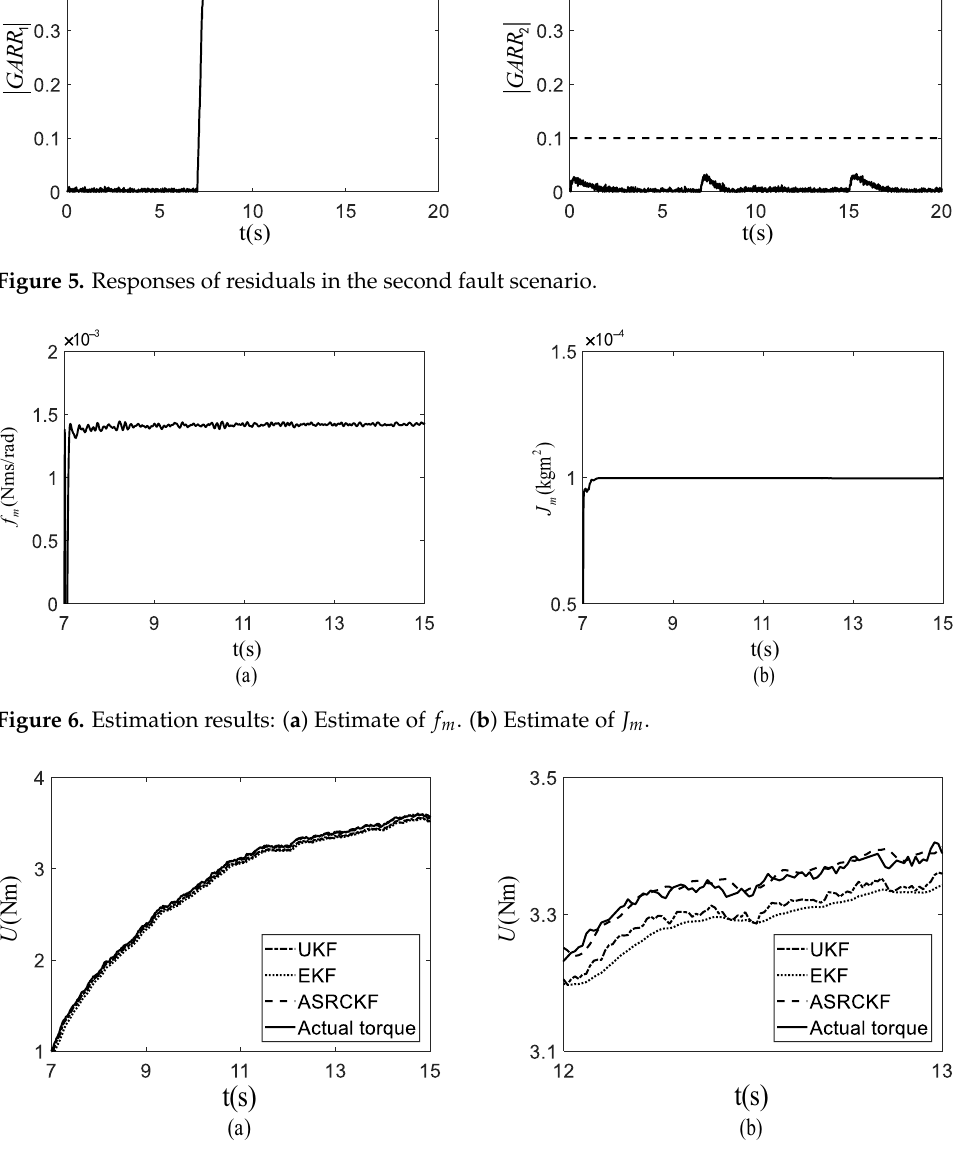
Figure 7. Estimation results: ( a ) Estimate of U . ( b ) Partial magnification of U